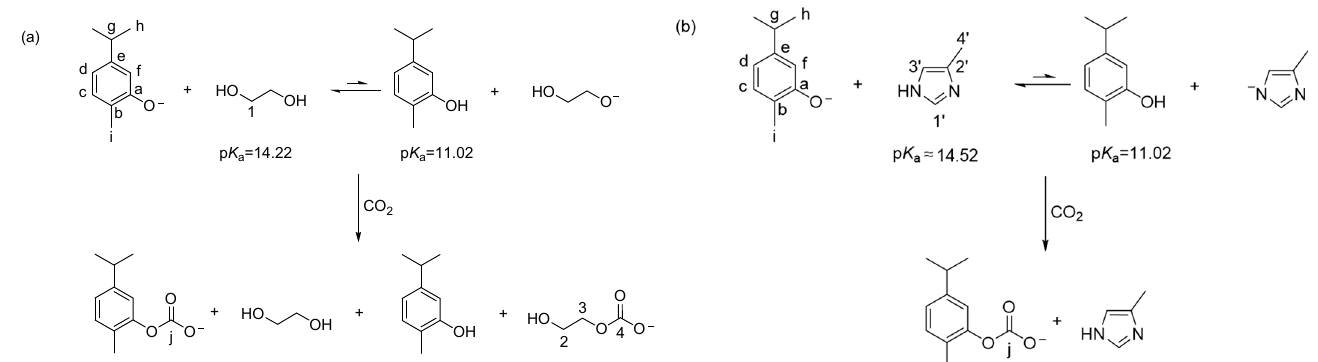
Scheme 2. The possible reaction mechanisms of CO 2 with [Et 4 N] [Car]:EG (1:2) ( a ) (the reaction between [Et 4 N] [Car]:EG (1:2) and CO 2 .) and [Et 4 N] [Car]:4CH 3 -Im (1:2) ( b ) (the reaction between [Et 4 N] [Car]:4CH 3 -Im (1:2) and CO 2 .). Letters from